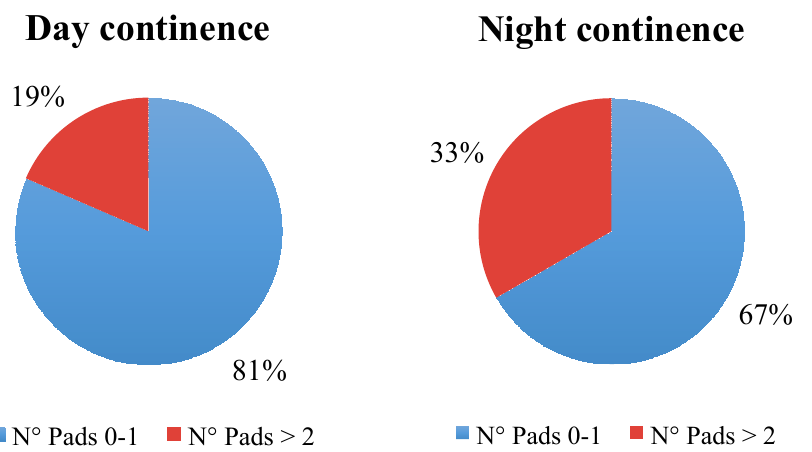
Figure 4. Daytime and night-time continence recovery rate after removal of patients with incomplete follow-up data.